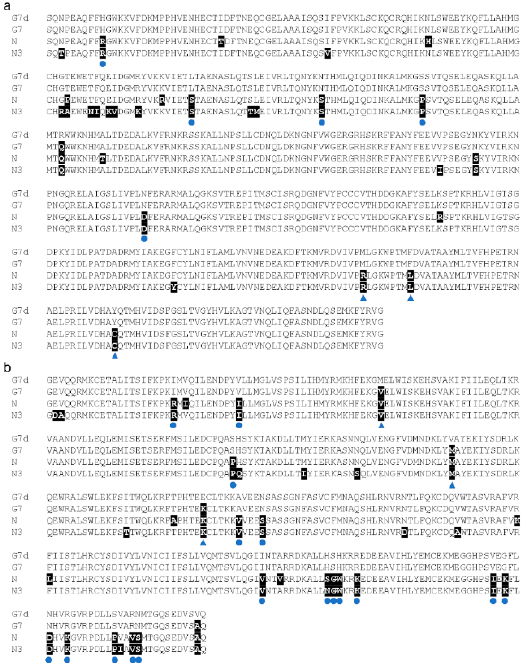
Figure 4. Multiple alignment of the partial amino acid sequences of SMV N3, N, G7, and G7d. ( a ) HcPro. ( b ) P3. Varied residues are highlighted in black, residues that are involved in the evading Rsv1 -mediated resistance have been indicated by blue triangles, and residues consistent in N and N3 are indicated by blue dots.